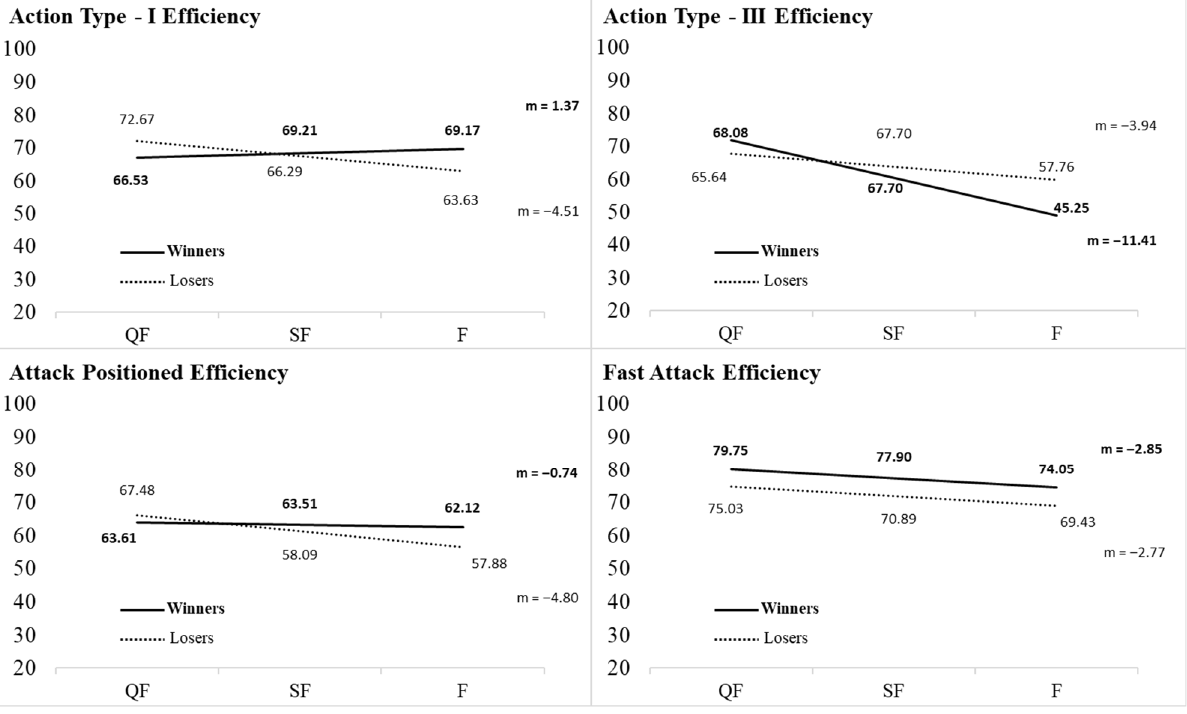
Figure A3. Linear tendency lines of game action. Note: QF= Quarterfinals; SF= Semifinals; F= Finals.